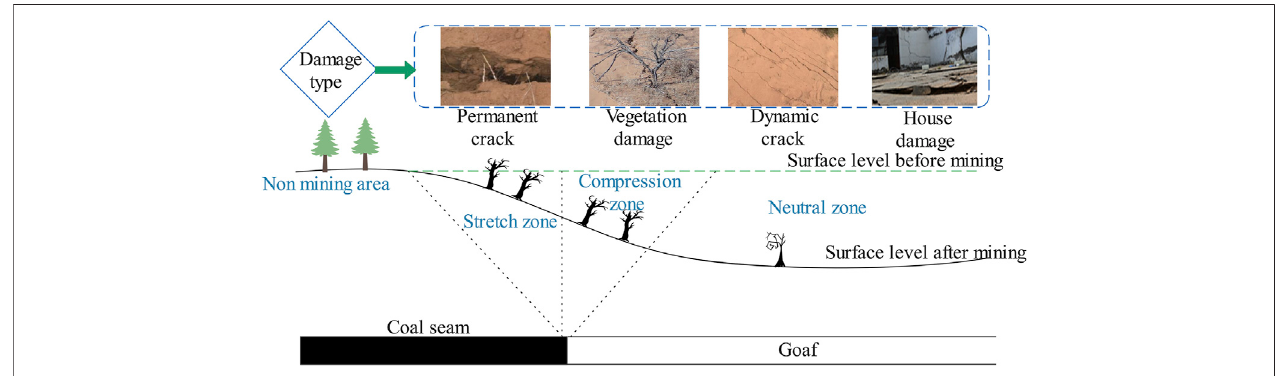
FIGURE 1 | Surface ecological damage in mining